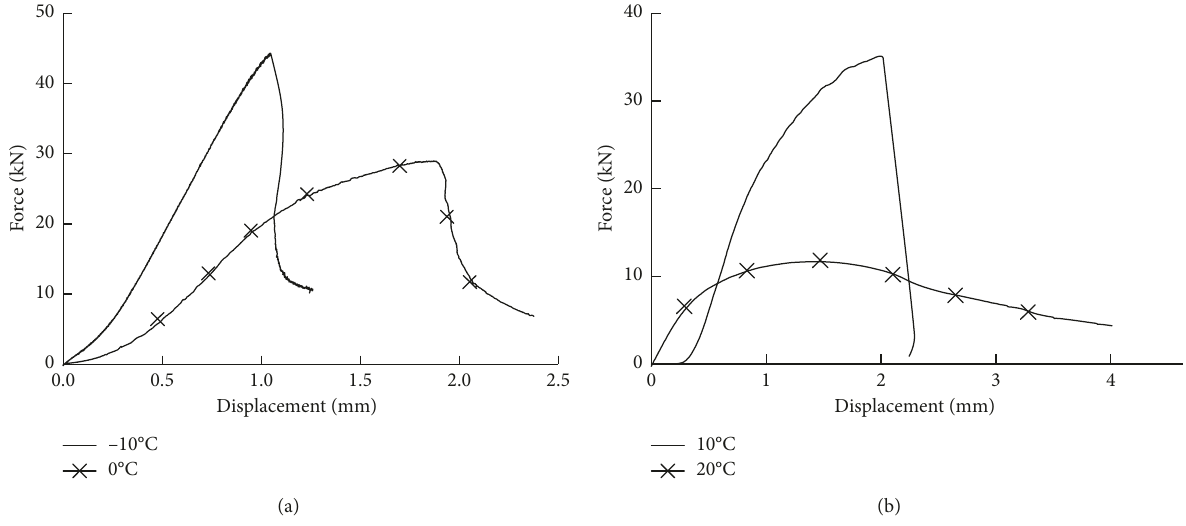
Figure 10: Splitting test results of AC-13. Load-displacement curve: (a) − 10 ° C and 0 ° C and (b) 10 ° C and 20 ° .